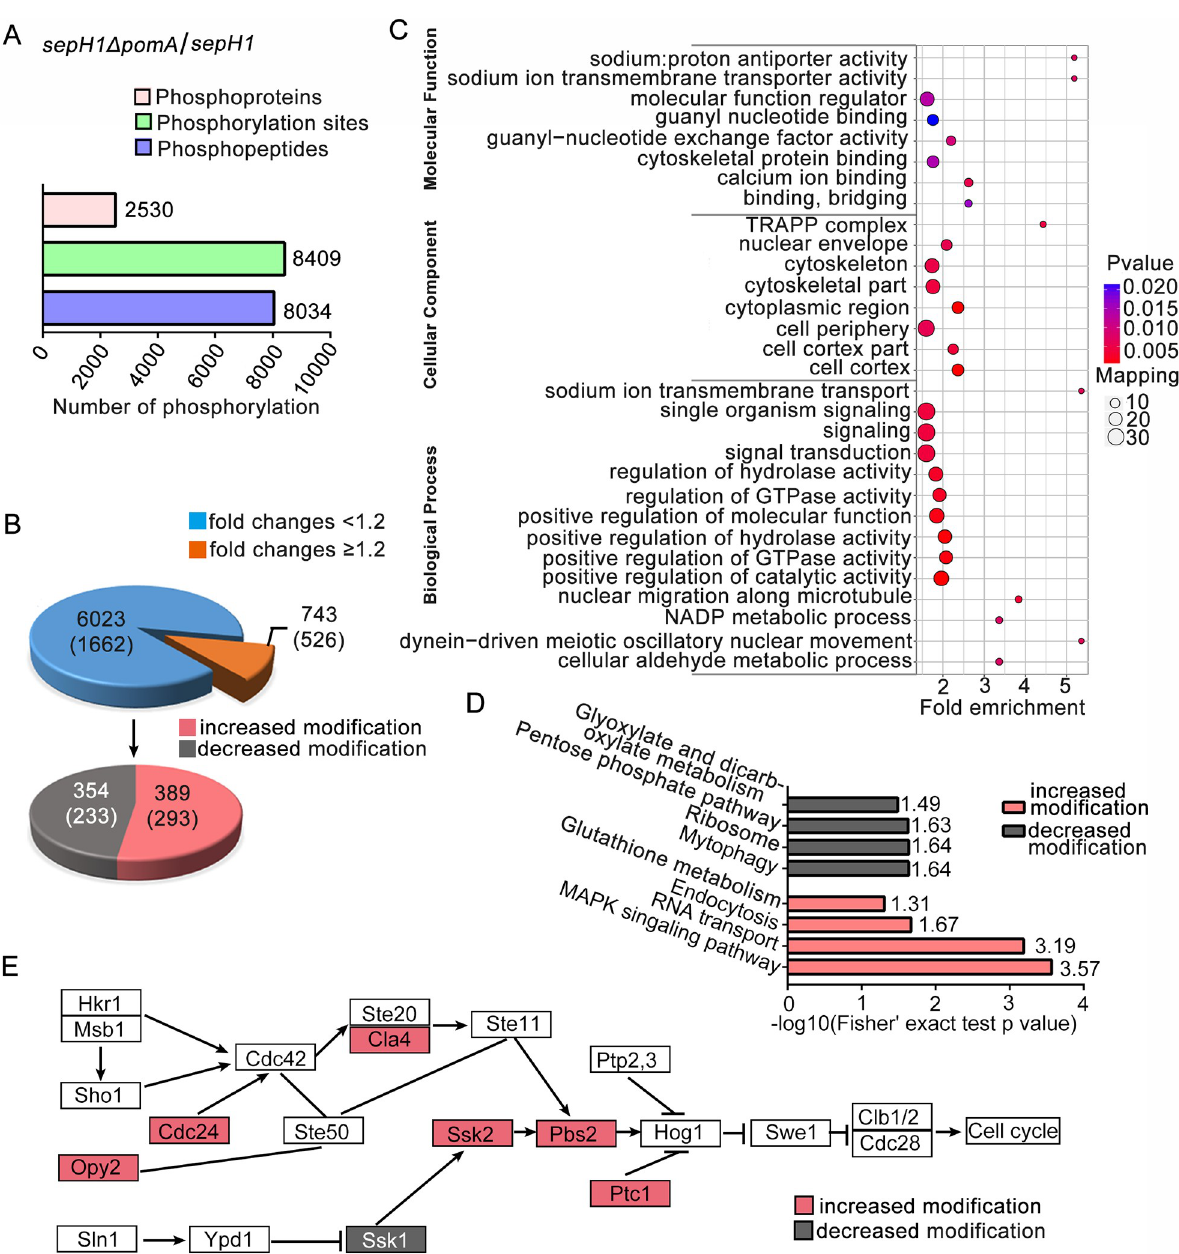
Fig 4. Quantitative phosphoproteomics comparison between the septa-restored strain sepH1 Δ pomA (ZXA10) and the septa-abolished control strain sepH1 revealed that the deletion of pomA activated the HOG pathway. (A) Total number of detected phosphorylation sites, peptides and proteins and (B) fold changes of phosphorylated proteins. (C) GO terms enriched for all phosphorylated proteins and (D) KEGG pathways enriched in phosphorylated proteins with more than 1.2-fold changes. (E) Visual analysis of the increased phosphorylated proteins in the MAPK pathway (labeled in